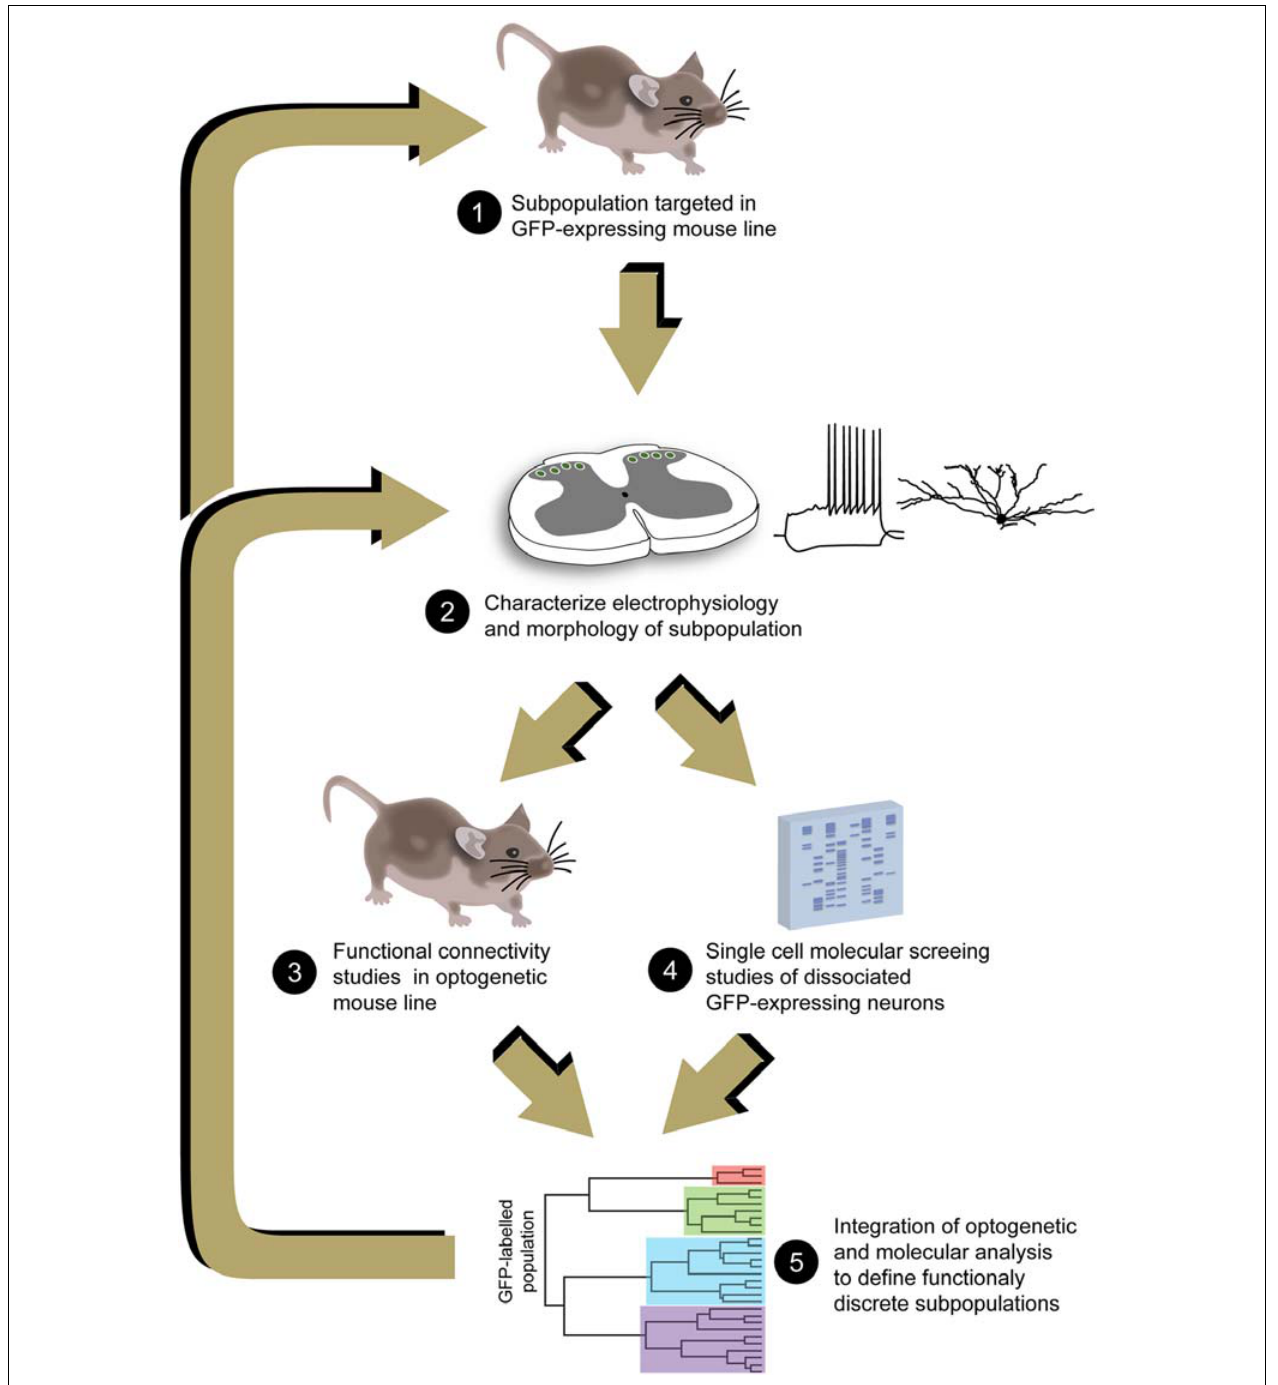
circuits (3). GFP-expressing populations can also be subjected to gene expression profiling to further dissect any remaining heterogeneity and identify novel proteins that are selectively expressed in these subpopulations (4). This information can then be fed back into the analysis strategy, further refining the selection of probes to target smaller DH subpopulations, and identifying unique function and neuroanatomical features that can then be used to identify these